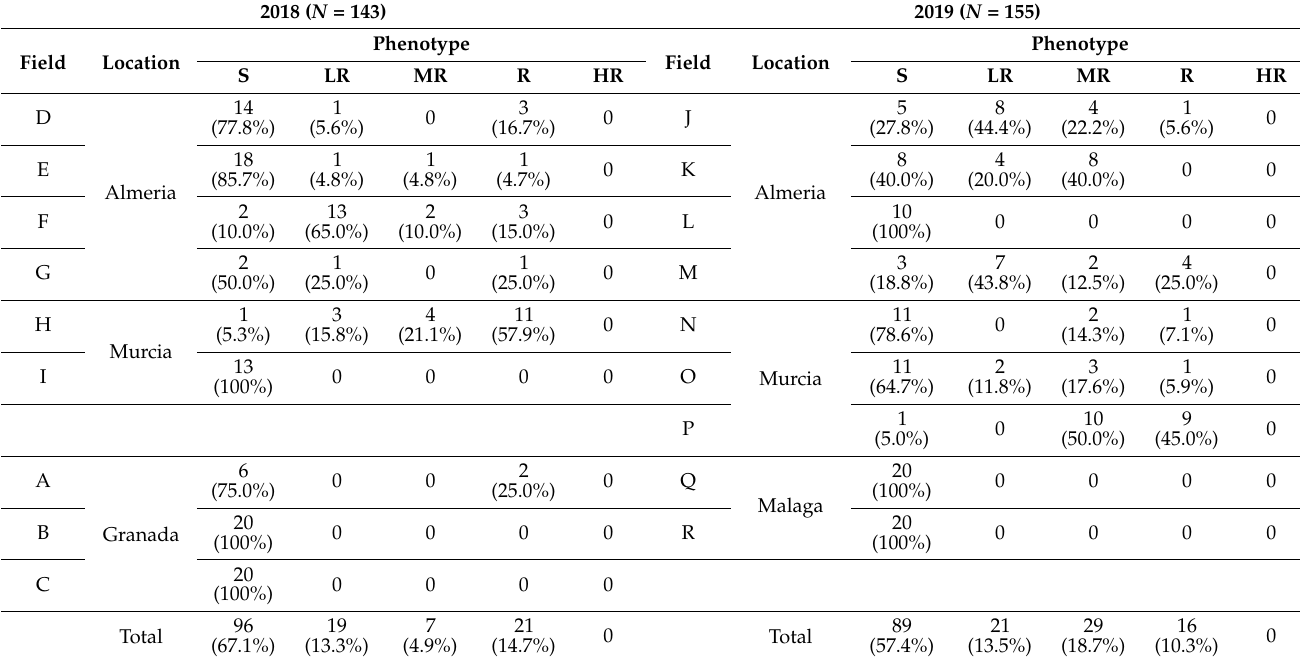
Table 3. Number and frequencies of boscalid-sensitive and -resistant P. xanthii isolates collected from four different cucurbit production areas in Spain during 2018 and 2019 growing seasons.